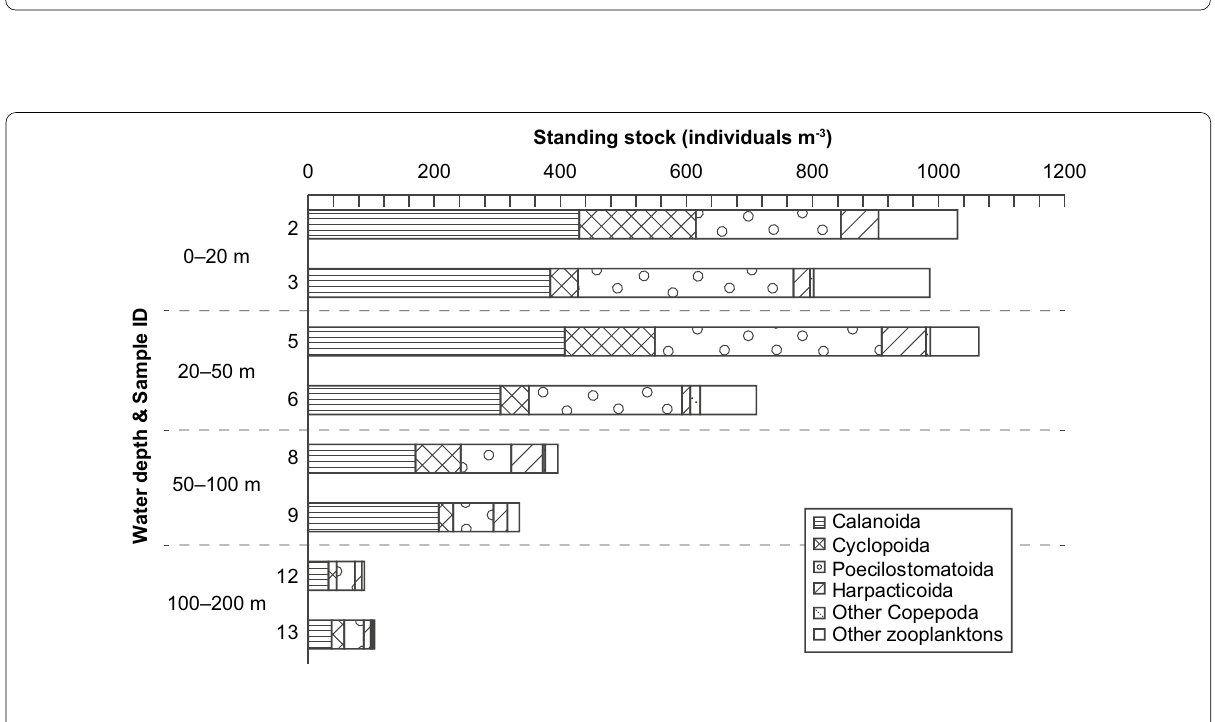
Fig. 4 Standing stocks of living zooplankton at four depth intervals (0–20, 20–50, 50–100, and 100–200 m; two replicates) in Suruga Bay,